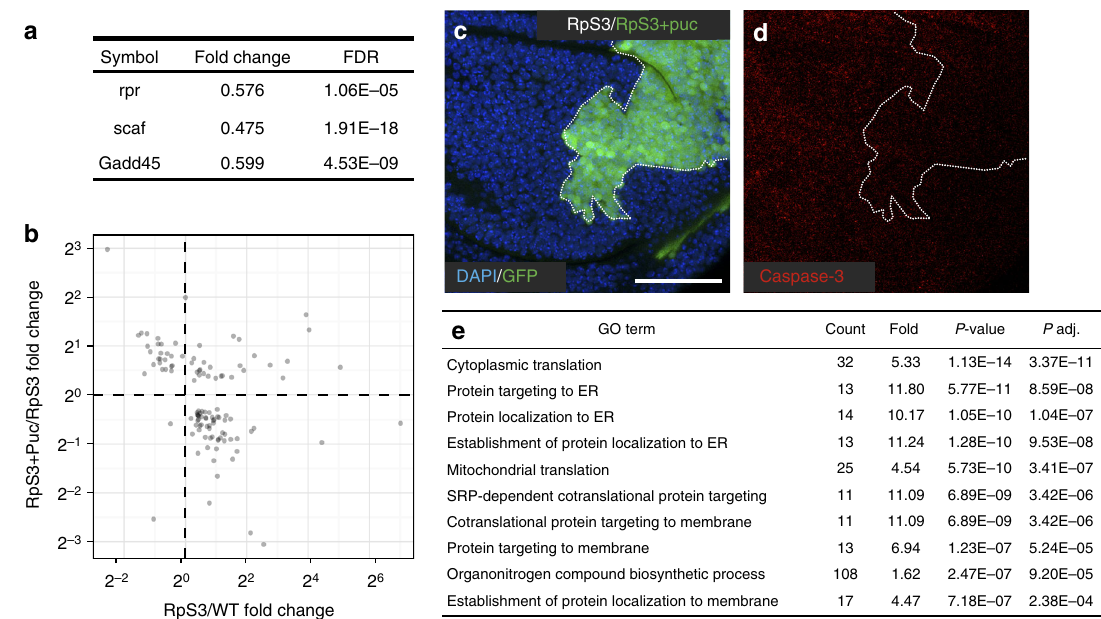
Fig. 3 JNK inhibition partially reverts the molecular signature in RpS3 + / − cells and increases the expression of translation-related genes. a List of known JNK targets that become downregulated on overexpression of the JNK-speci fi c inhibitor puckered ( puc ) in RpS3 + / − wing discs. b Plot showing fold changes in gene expression ( RpS3 +puc/ RpS3 , y axis; RpS3 /WT, x axis) for those genes that are differentially expressed in RpS3 + / − cells upon JNK inhibition vs. RpS3 + / − cells and that are also present in the prospective loser signature. c , d RpS3 + / − wing discs harbouring GFP-positive clones overexpressing puc ( c ) and stained with anti-cleaved caspase-3 ( red , d ). Note the absence of localised cell death at the clonal boundary ( d ). Detailed genotypes are listed in Supplementary Table 1. e Table of ten most highly enriched GO terms amongst genes that become upregulated on JNK inhibition in RpS3 + / − cells with the number of genes (count), fold enrichment, P value and P -adj